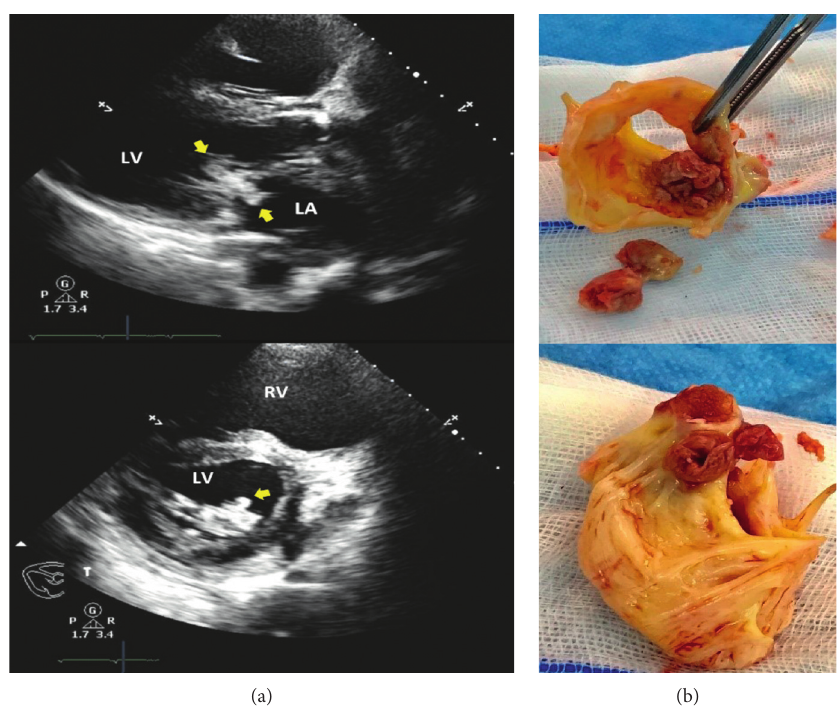
Figure 1: (a) Transthoracic echocardiogram showing multiple oscillating masses (yellow arrows) at anterior mitral valve leaflet with severe rheumatic mitral stenosis. (b) Gross findings of the resected mitral valve showing three large vegetations at anterior mitral valve leaflet. LV, left ventricle; LA, left atrium; RV, right ventricle.